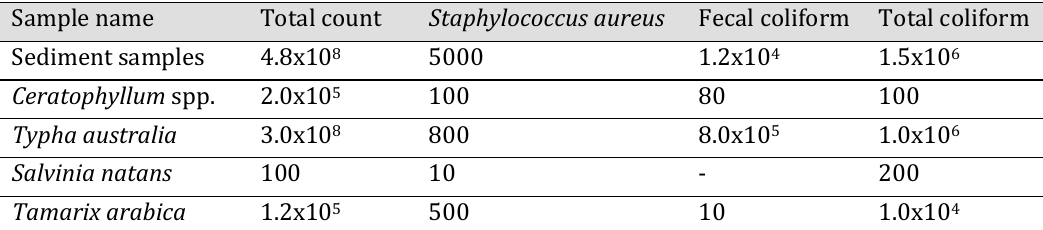
Table 2. Bacteriological analysis of sediments and various plants samples from Al-Chebaysh